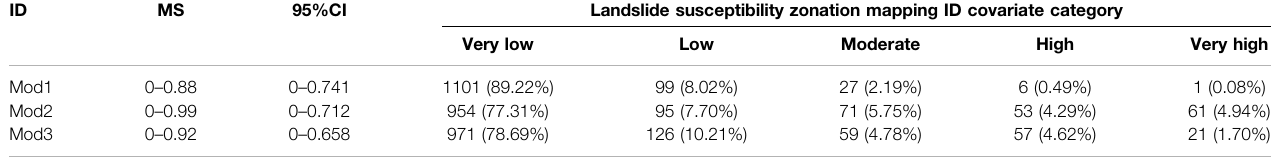
TABLE 4 | Mean susceptibility (MS) and its classi fi cation (the count of SUs in each class and their percentages), as well as 95% con fi dence interval, (CI) for each susceptibility model.